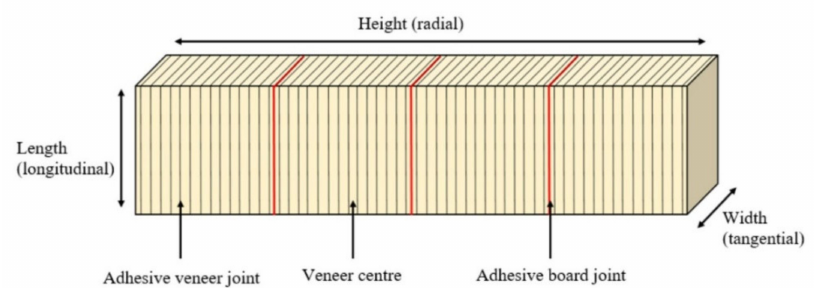
Figure 1. Schematic representation of an LVLB test specimen. Red lines highlight the adhesive joints between the individual laminated veneer boards at 40, 80 and 120 mm.